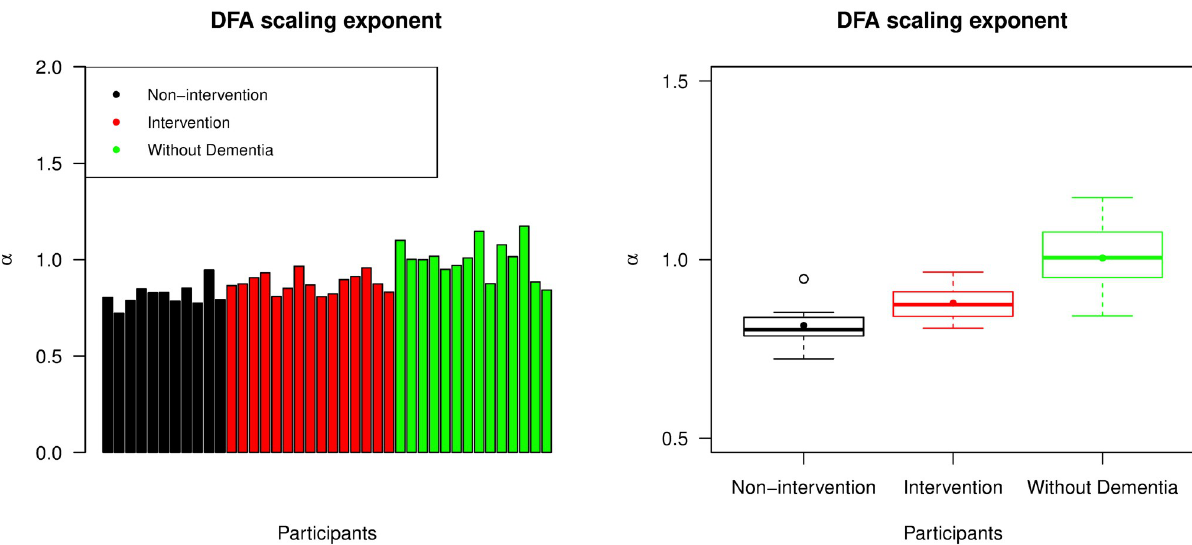
Fig 6. DFA scaling exponents ( α ). The left panel displays α values across all participants, with the same ordering of individuals as the bar chart representing IS values; the right panel is a box plot collating α values across the non-intervention group, the intervention group, and the group of individuals without dementia. For each group, the median and mean of the α values are presented by a thick line and a point in its own box, respectively.